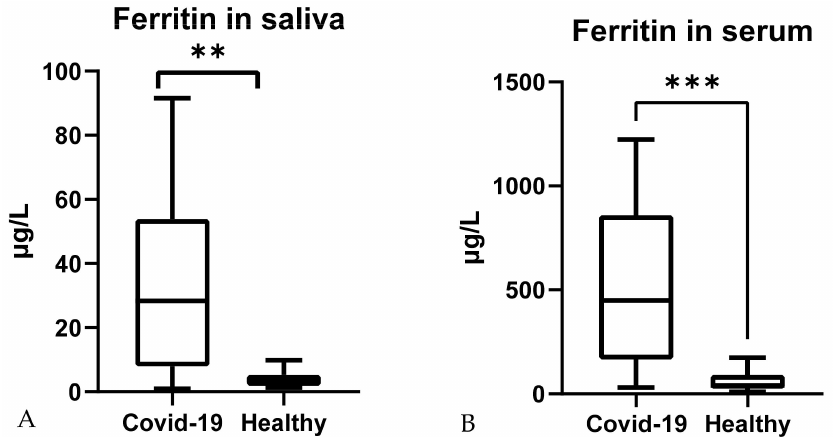
Figure 2. Ferritin concentrations in n = 32 saliva ( A ) and serum ( B ) of paired samples from healthy individuals and COVID-19 patients. **: p < 0.01; ***: p <